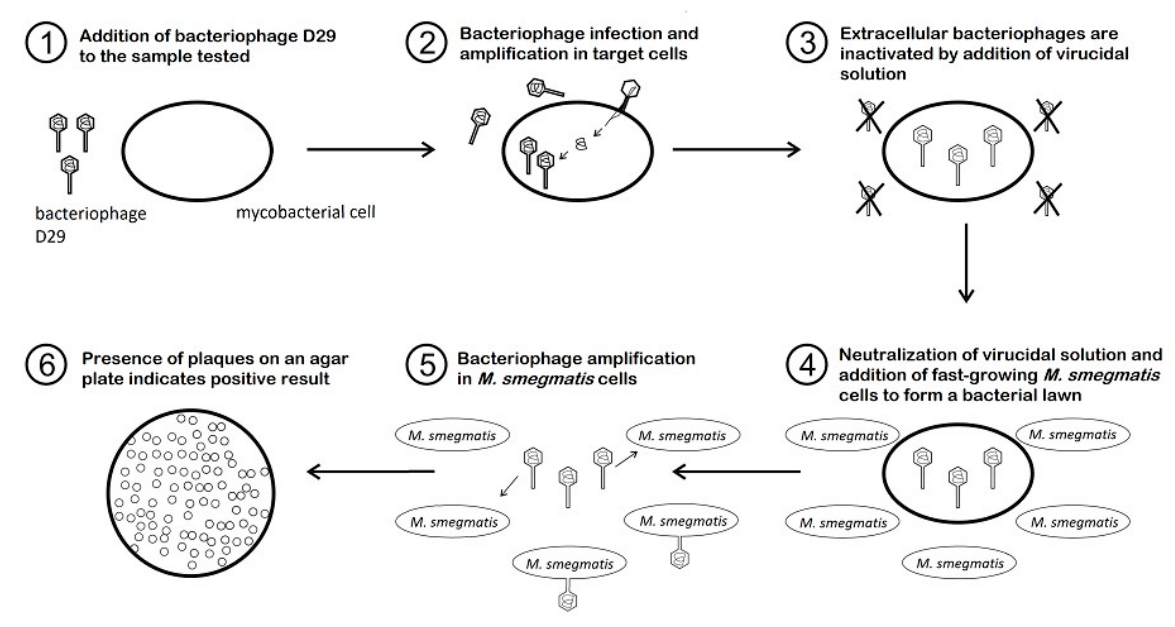
Figure 1. The schematic representation of the phage amplification assay methodology.